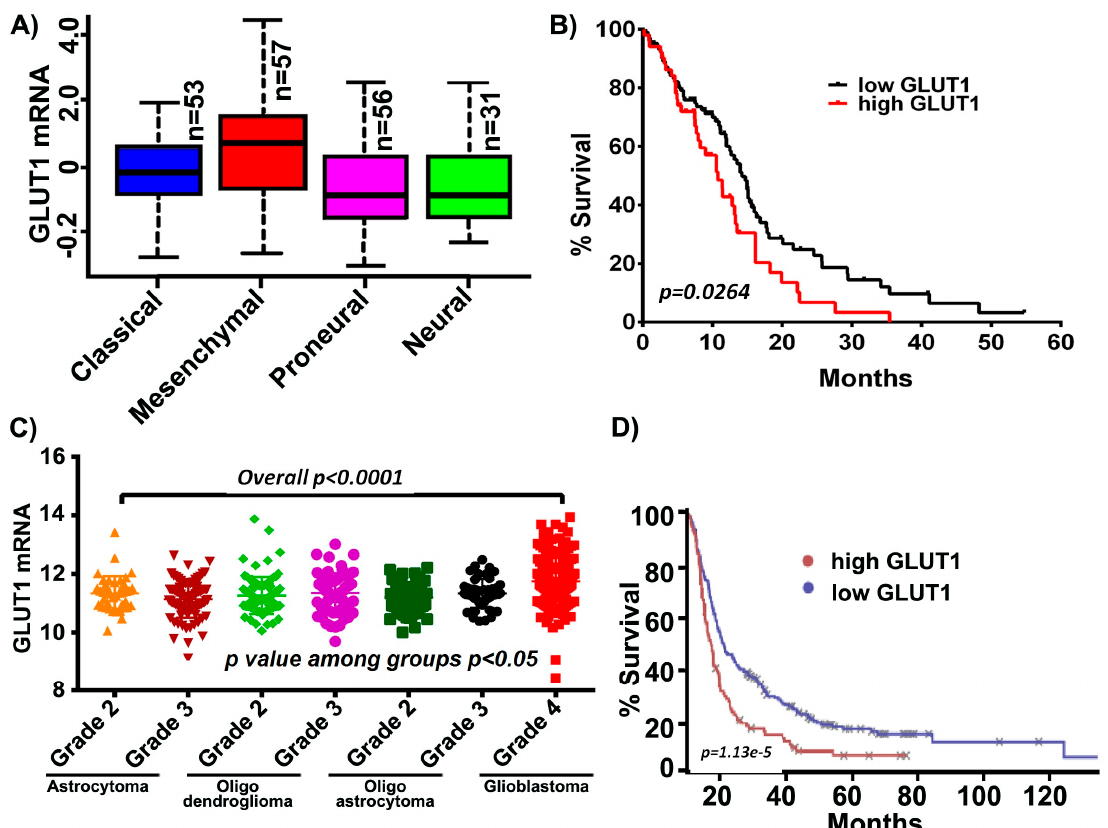
Figure 1. GLUT1 expression in The Cancer Genome Analysis (TCGA) and Repository for Molecular Brain Neoplasia Data (REMBRANDT) cohort. ( A ) GLUT1 expression is high in the mesenchymal subtype compared to other glioblastoma multiforme (GBM) subtypes. ( B ) Kaplan-Meier curves show increased GLUT1 corresponds to decreased survival. ( C ) GLUT1 is highly expressed in GBM relative to lower grade glioma ( p < 0.0001). ( D ) Survival analysis of long-term survivors from the REMBRANDT dataset show that the patients with high GLUT1 expression show shorter overall survival.